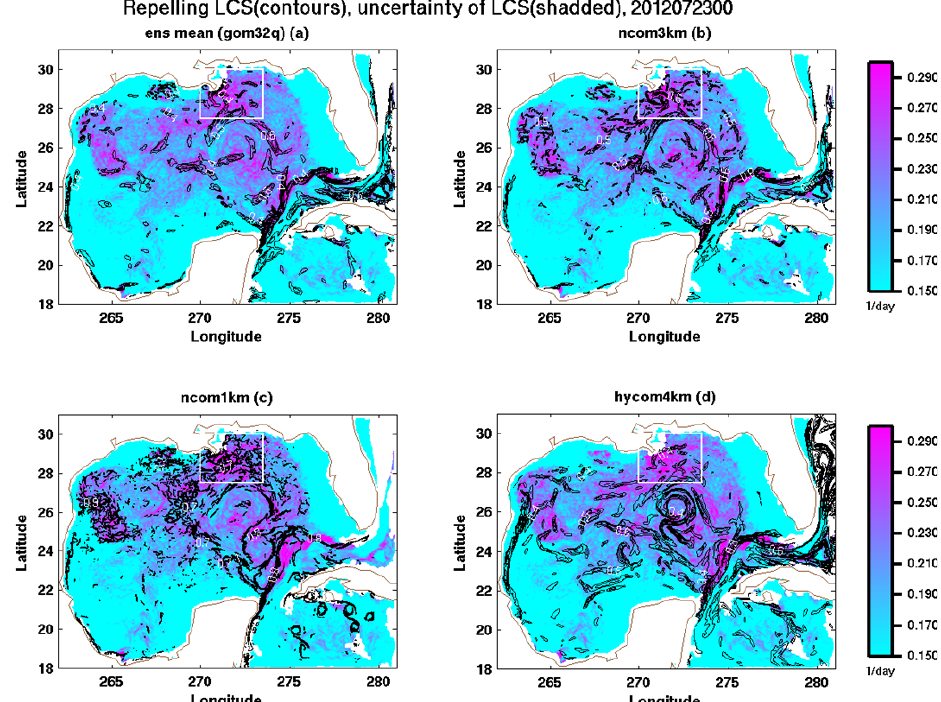
Fig. 11. The repelling LCSs (black contours) and their associated uncertainties of LCS (from gom32q, color shaded) on the ocean surface over the GOM at 00:00UTC, 23 July 2012, generated by ensemble mean of gom32q (a) , ncom3km (b) , ncom1km (c) , and hycom4km (d) .